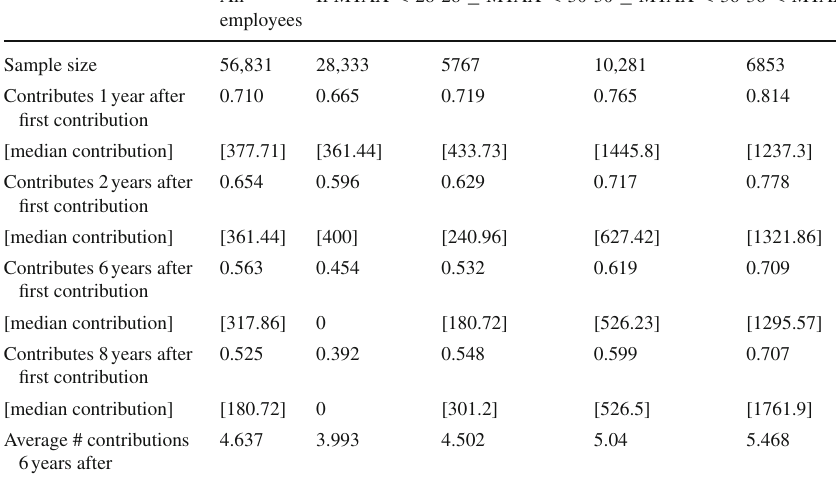
Table 10 Do contributors persist contributing? Source : Panel of tax returns (1988–1998). The sample in the second panel only contains observations on filers who report only income as